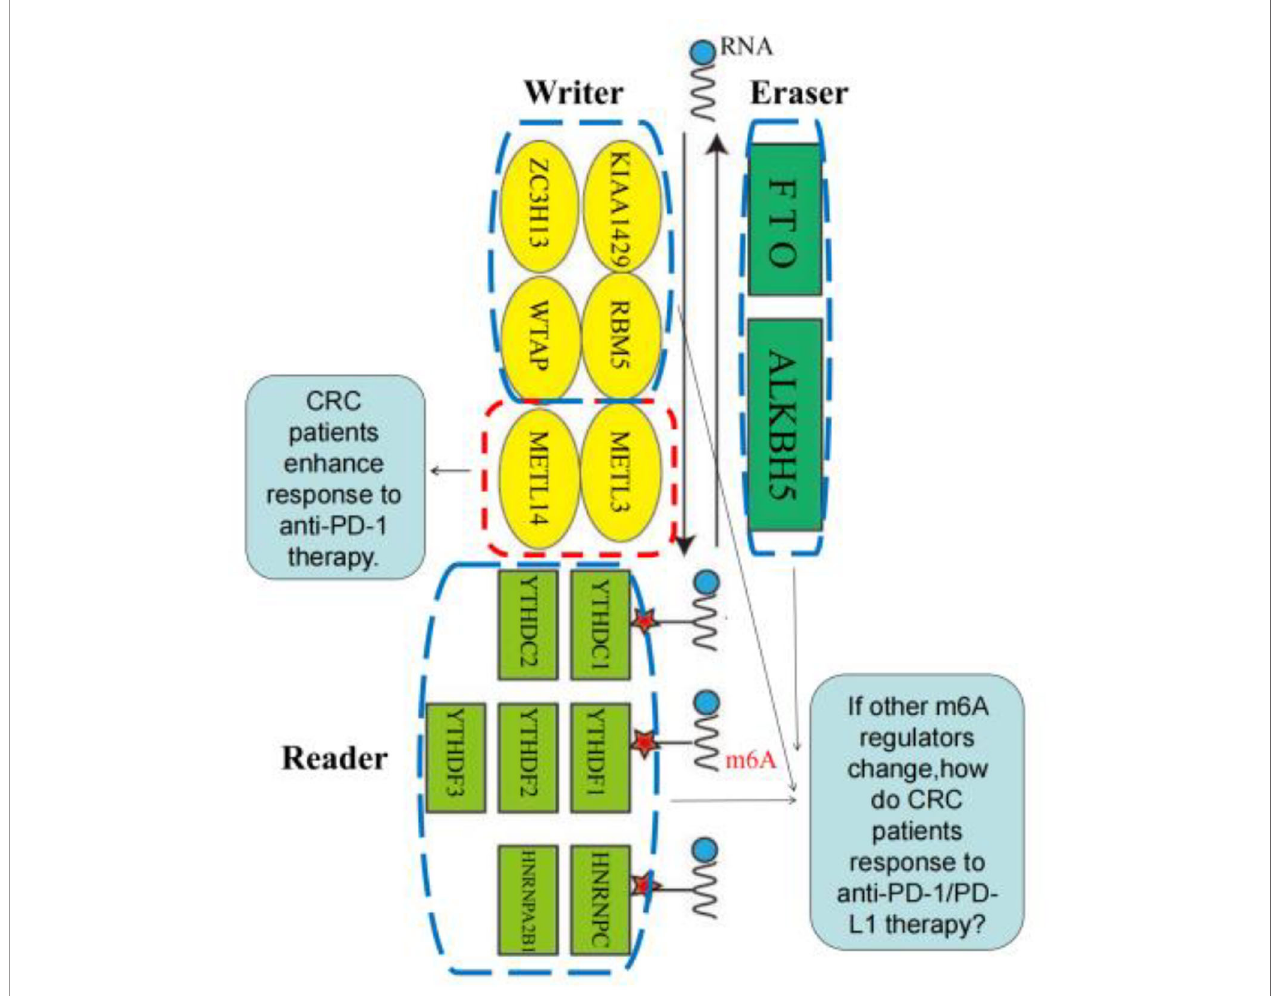
FIGURE 3 | m6A regulators, including “ writer ” (methyltransferase), “ reader ” (signal converter) and “ eraser ” (demethylation